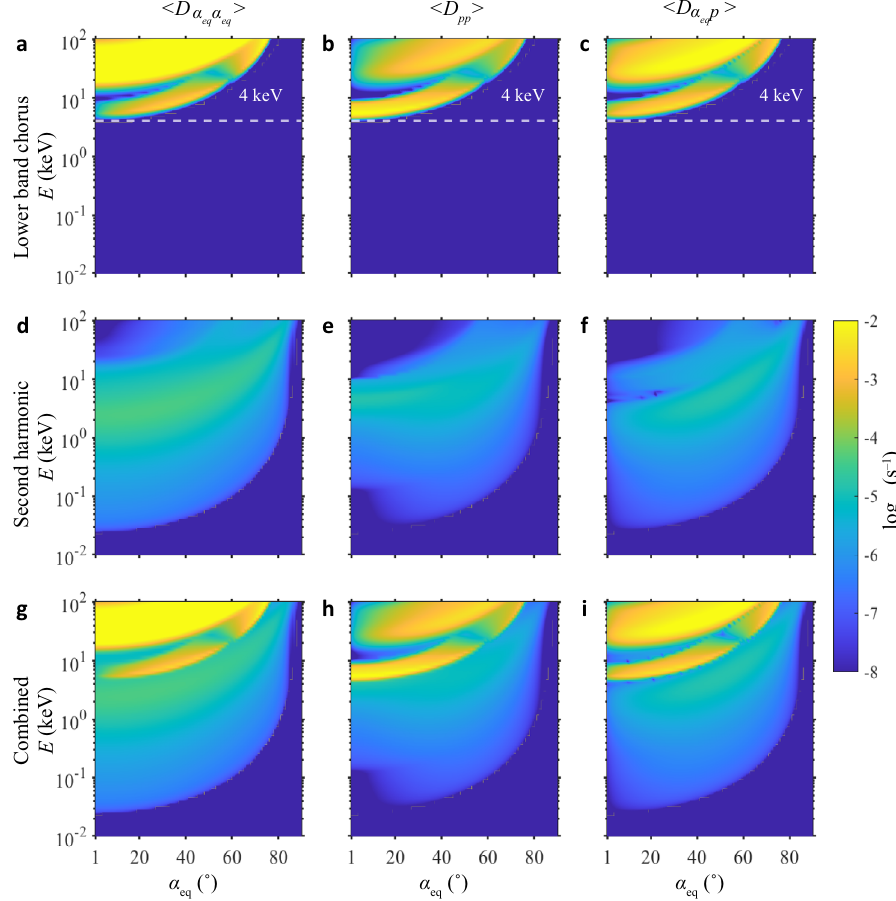
Fig. 3 | Bounce-averaged pitch-angle (< D α >), momentum (< D pp >), and eq α eq mixed (< D α >) diffusion rates as a function of electron energy (E) and equa- eq p torial pitch angle ( α eq ). a – c Lower-band chorus only cause electron diffusions in energy above 4keV (dashed white lines). d – f Second-harmonic emissions can